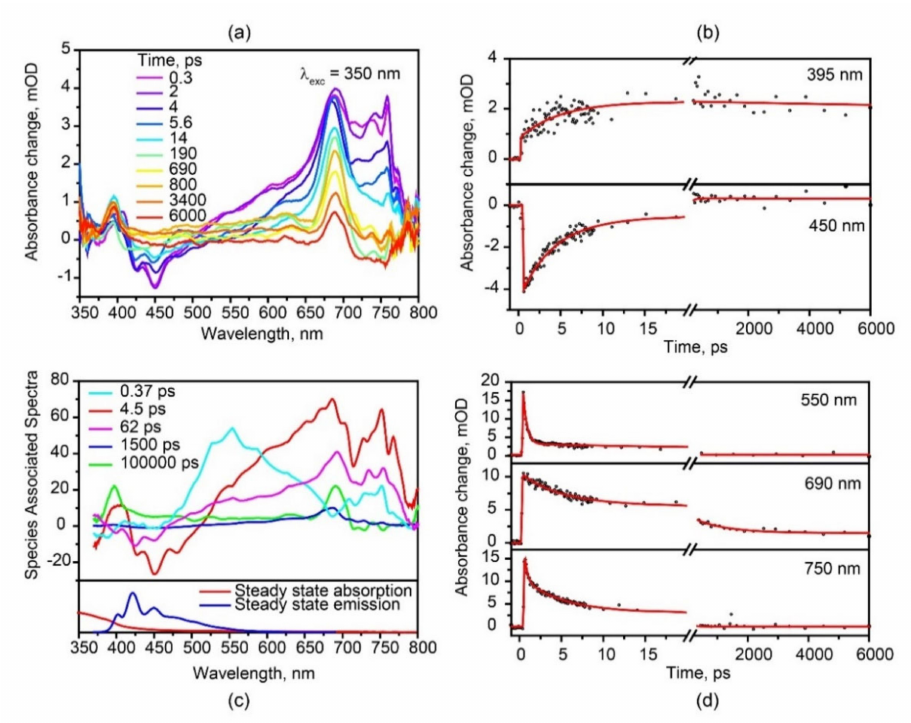
Figure 3. Transient absorption spectra ( a ) and Species Associated Spectra by global fit ( c ) of